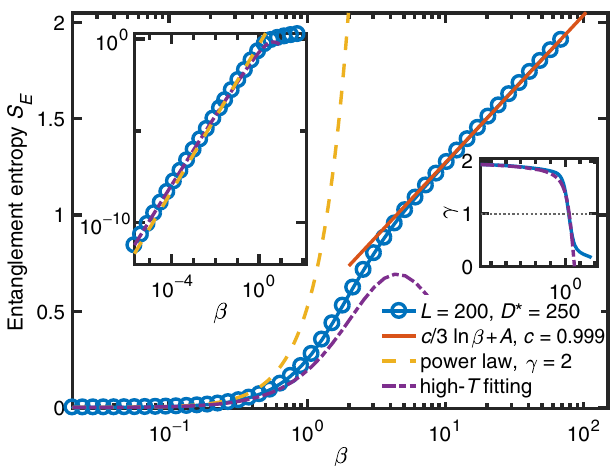
FIG. 11. Bipartite MPO entanglement S E across the center of the system in an OBC Heisenberg chain of length L ¼ 200 . At low temperatures ( β ≥ 10 ), S E diverges logarithmically. The line in the main panel for large β (small T ) is a fitting to S c= 3 ln β þ const, with central charge c ≃ 0 . 999 determined E ¼ by fitting the range β > 12 . The left inset shows the same data on a log-log plot, which emphasizes a power law of entanglement versus β for β ≲ 1 . The purple dashed lines represent the fit in Eq. (13) with α ¼ 0 . 05 , while the yellow dashed lines represent β 2 as a guide to the eye. The right inset shows the slope of the log- log data in the left inset, i.e., the power-law exponent γ of the entanglement versus β